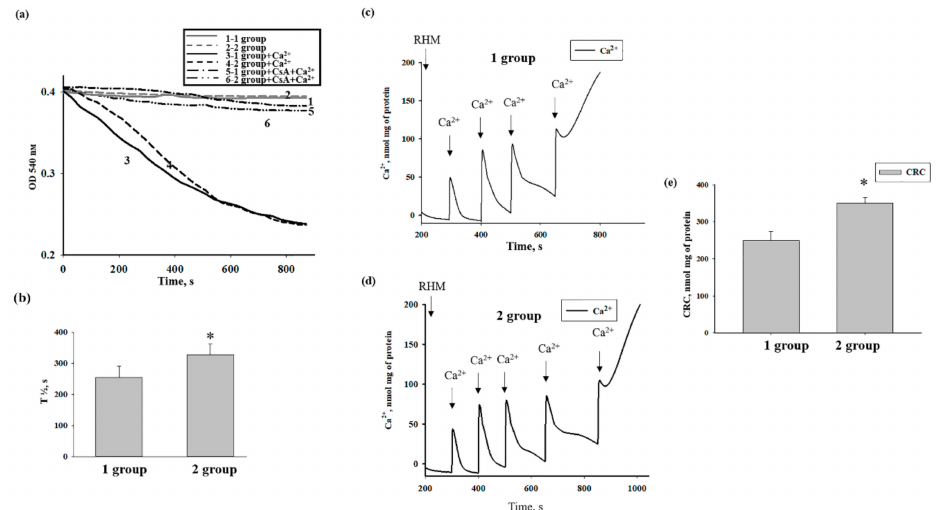
Figure 6. The e ff ect of AST administration on mitochondrial swelling and CRC in RHM isolated from each group. ( a ) Curves of RHM swelling; ( b ) half-maximum of mitochondrial swelling (T 1 / 2 ); ( c , d ) Ca 2 + transport in RHM isolated from each group; ( e ) quantitative analysis of CRC in